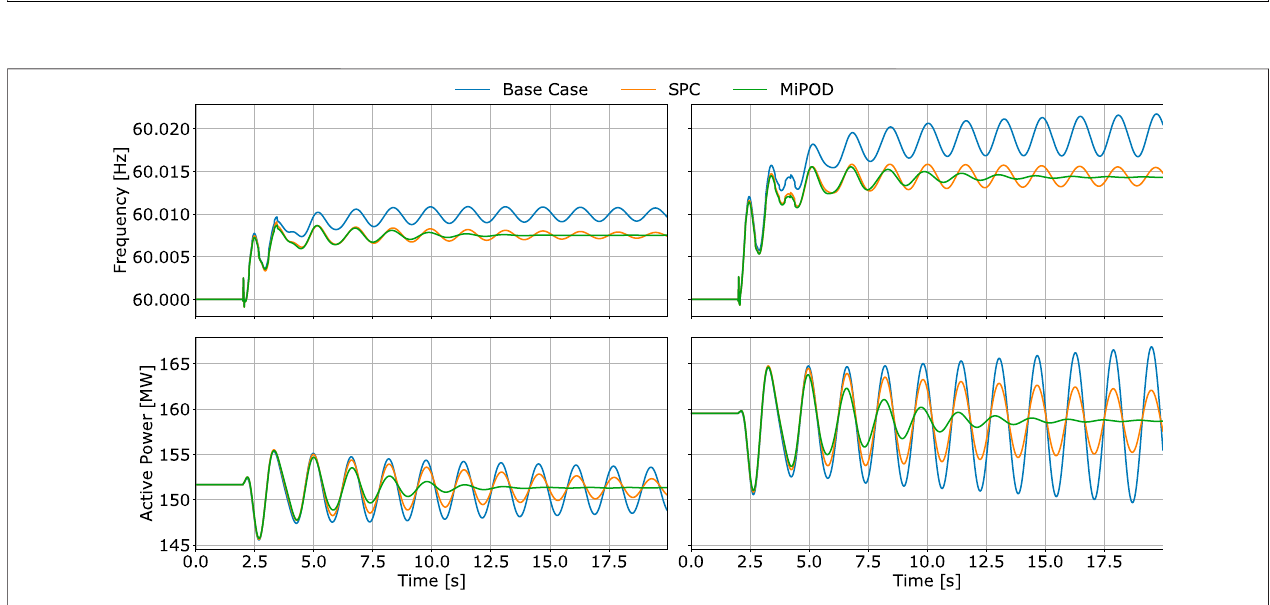
FIGURE 18 | System frequency and active power fl ow at B08 after a sudden change in the mechanical torque of G3 and G4 for 2 random operating points.